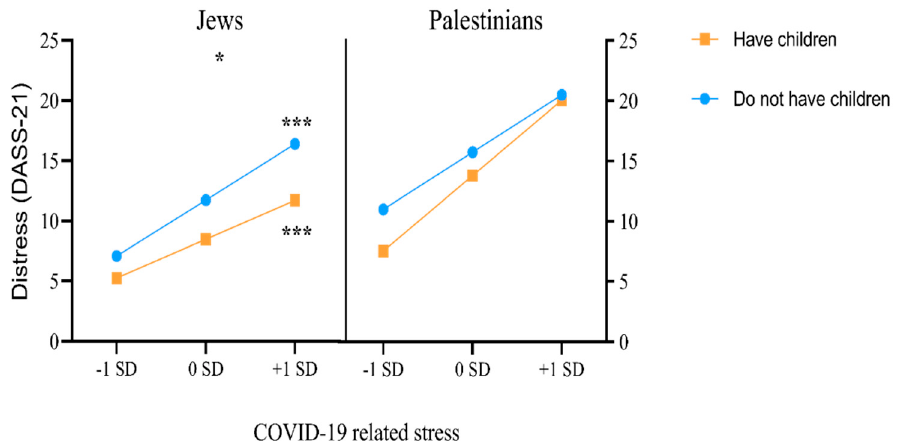
Figure 1. Differences between the Palestinian minority and the Jewish majority for the moderating effect of parenthood on the association between COVID-19-related stress and distress. *** p < 0.001, * p < 0.05. DASS-21: Depression, Anxiety, and Stress Scale.